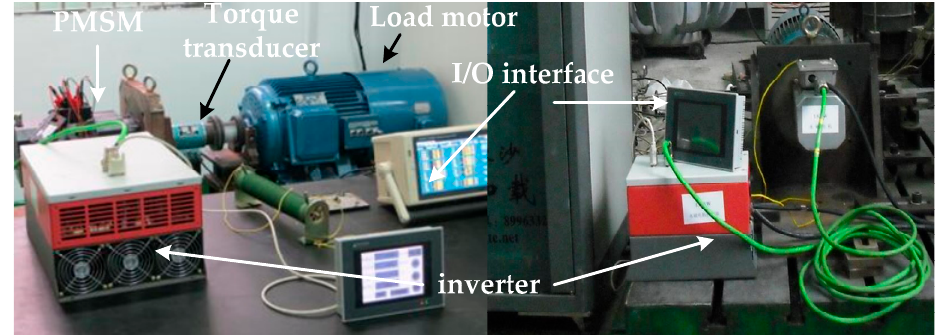
Figure 13. Laboratory prototype of current trajectory control with sampling frequency f = 5 kHz.